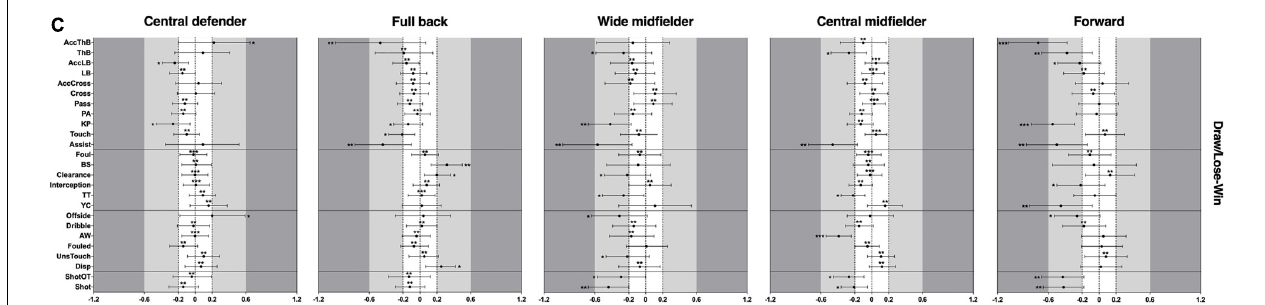
FIGURE 1 | Standardised effects of playing positions and competing situations on the technical variation (CV) of players. Part labels (A–C) displayed the differences in technical variation of 5 playing positions under the competing situations of competition stage and match location, quality of team and opponent, match outcome, respectively. Bars are 90% confidence intervals. Asterisks indicate the likelihood for the magnitude of the true differences in mean as follows: *possible; **likely; ***very likely; ****most likely. Asterisks located in the trivial area denote for trivial differences. ShotOT, shot on target; Disp, player is dispossessed on the ball by an opponent-no dribble involved; UnsTouch, bad control; AW, aerial won; YC, yellow card; TT, total tackle; BS, blocked shot; KP, key pass; PA, pass accuracy in %; AccCross, accurate cross pass; LB, long ball; AccLB, accurate long ball; ThB, through ball; AccThB, accurate through